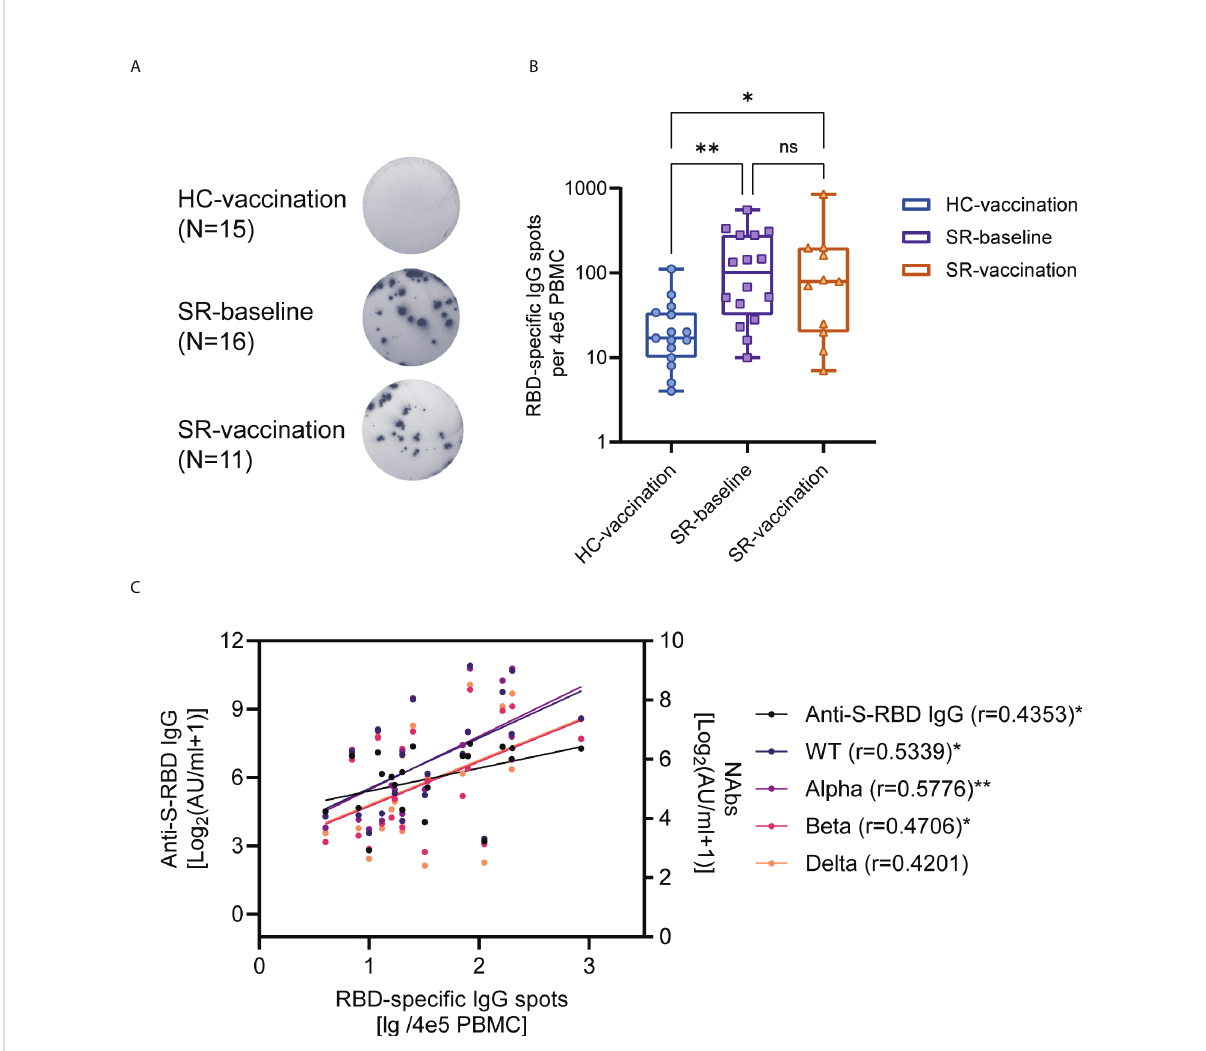
FIGURE 5 SARS-CoV-2 RBD-speci fi c B cell responses after booster vaccination. (A) ELISpot assay for representative RBD-speci fi c B cell spots in HC (Vaccination, N=15) and SR (Baseline, N=16; vaccination, N=11) subjects. (B) The comparison of the number of RBD-speci fi c ASCs between SR patients and HC individuals. (C) The correlation between RBD-speci fi c ASCs and antibody titers post-vaccination (N=21, HC-vaccination 10 samples, SR-vaccination 11 samples). Kruskal-Wallis test followed by Dunn ’ s multiple comparisons test (B) and Spearman ’ s rank correlation test (C) were used for statistical analysis. ns: no signi fi cance, * P < 0.05, ** P <0.01, HC: healthy control; SR: SARS-CoV-2 recovered patients. ASCs: antibody-secreting cells. The median (IQR) number of RBD-speci fi c ASCs for HC-vaccination group is 17(10-34), for SR-baseline group is 101 (32-280), and for SR-vaccination group is